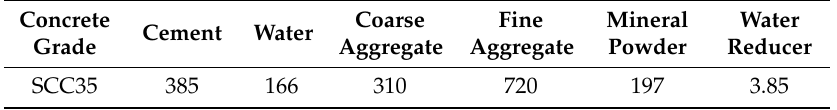
Table 1. Concrete mix proportion of self-compacting concrete (SCC) (kg / m 3 ).